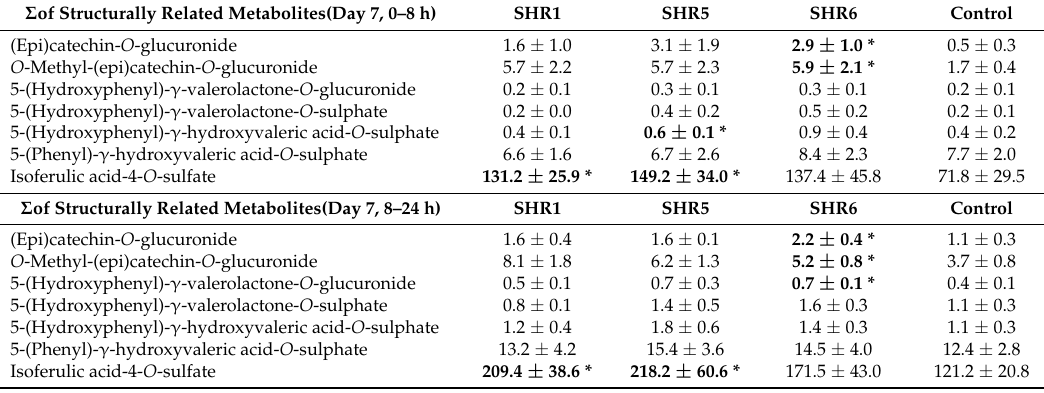
Table 4. Sum of structurally related urinary metabolites at day 7, 0–8 h and 8–24 h after ingestion of grape pomace extracts. Data are expressed as nmol ±